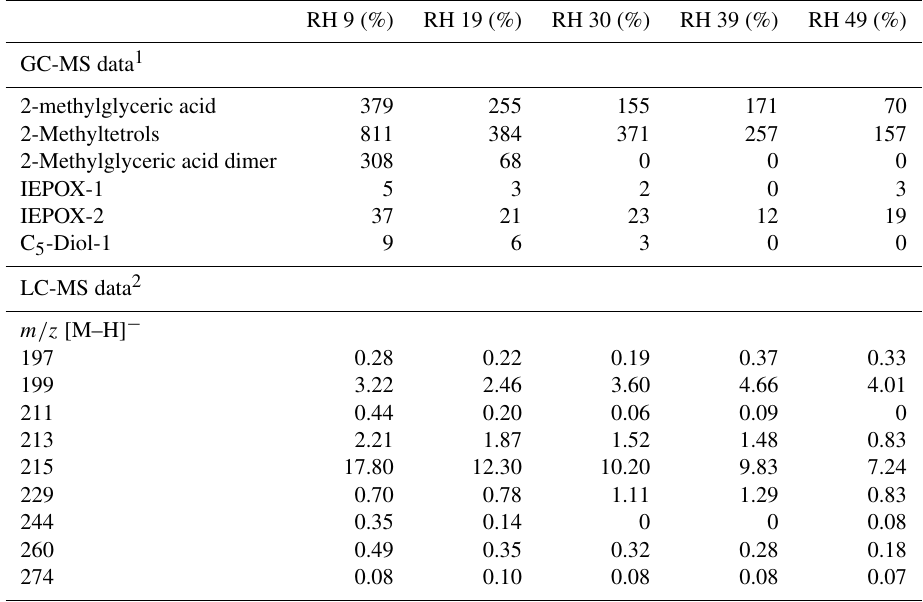
Table 3. Estimated concentrations of reaction products (ngm − 3 ) from the non-acidic photooxidation experiments (neutral seed [H + ] = 54nmolm − 3 air; Lewandowski et al., 2015).